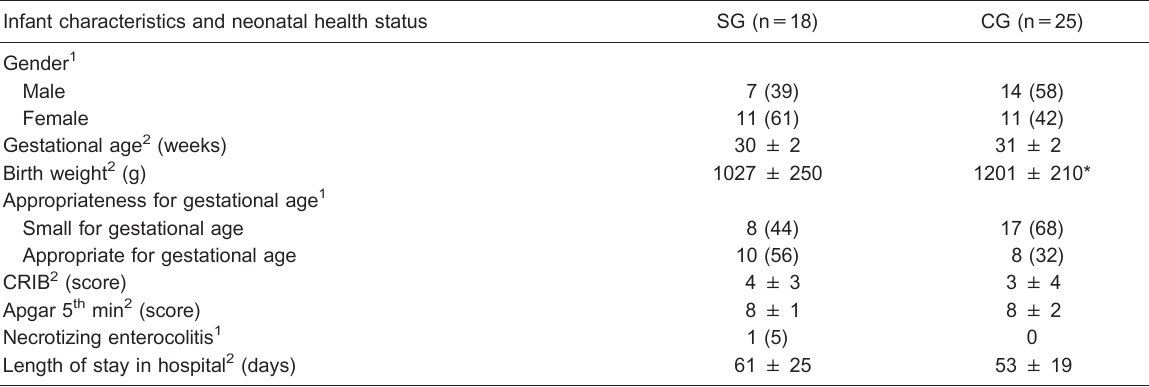
Table 1. Characteristics of preterm infants.